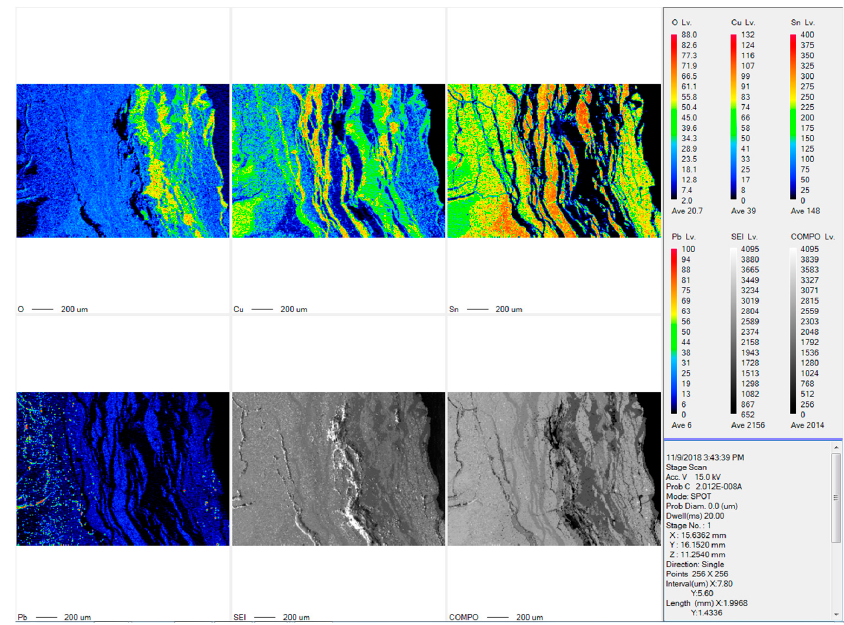
Figure 5. Ga-2 (No. 1) electron probe microanalyzer (EPMA) mapping